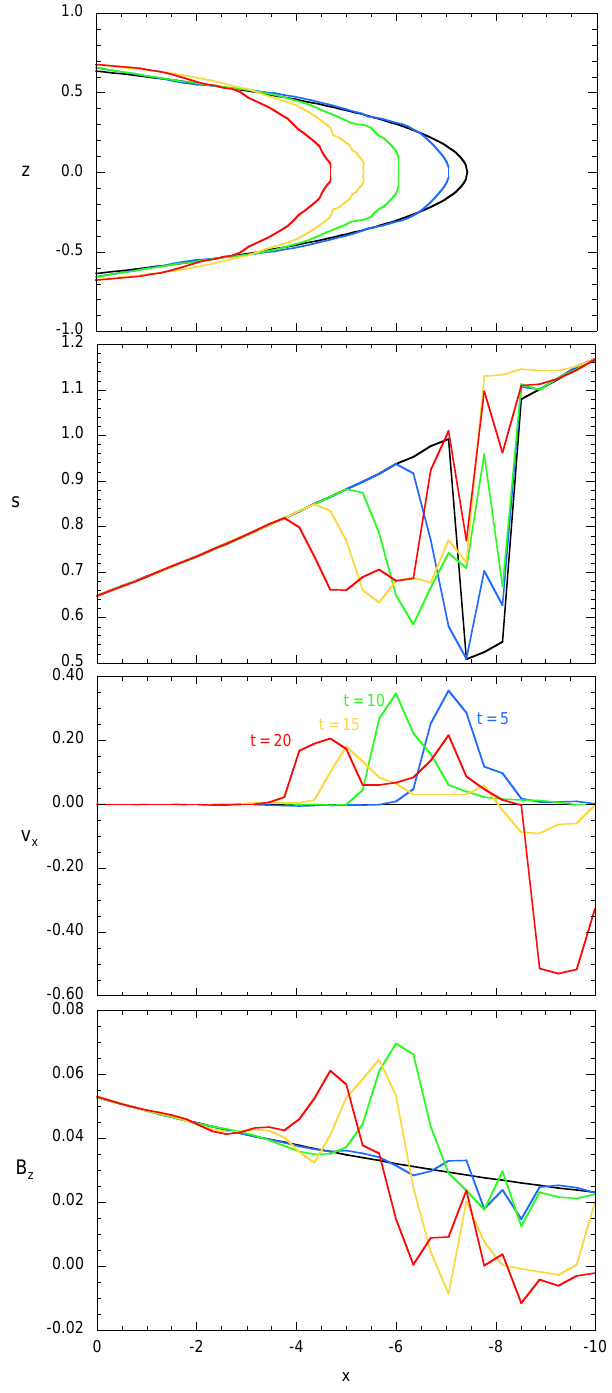
Fig. 9. Evolution of a depleted flux tube with y m = 0 . 02 along the x- axis, showing (from top to bottom) magnetic field lines at the inner edge of the bubble, the measure of specific entropy s = p 1 /γ /ρ , the velocity v x , and the magnetic field component B z as functions of x for different times, as indicated by the color coding and the labels given in the third